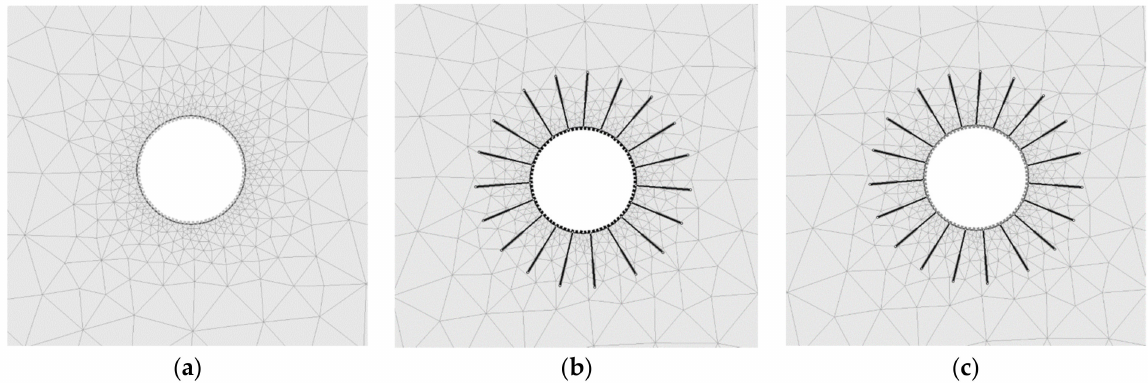
Figure 7. ( a ) Lining support; ( b ) bolt shotcrete support; ( c ) bolt shotcrete and lining